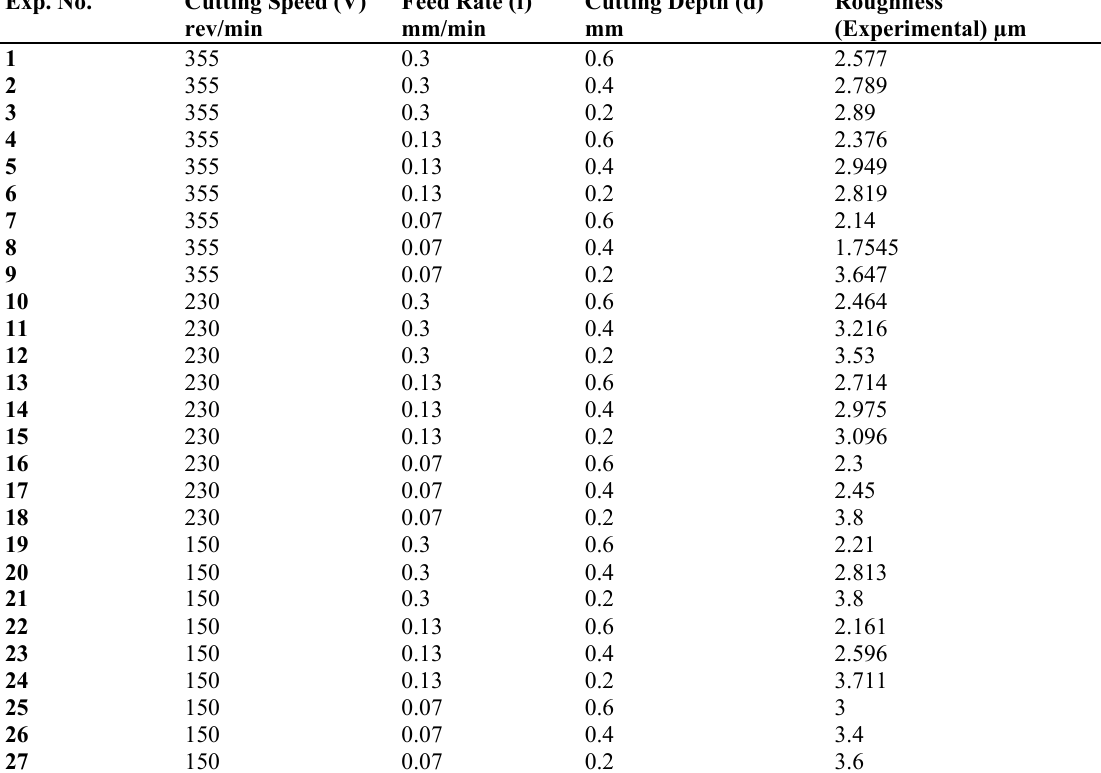
Experimental values of surface roughness Ra. Exp. No.